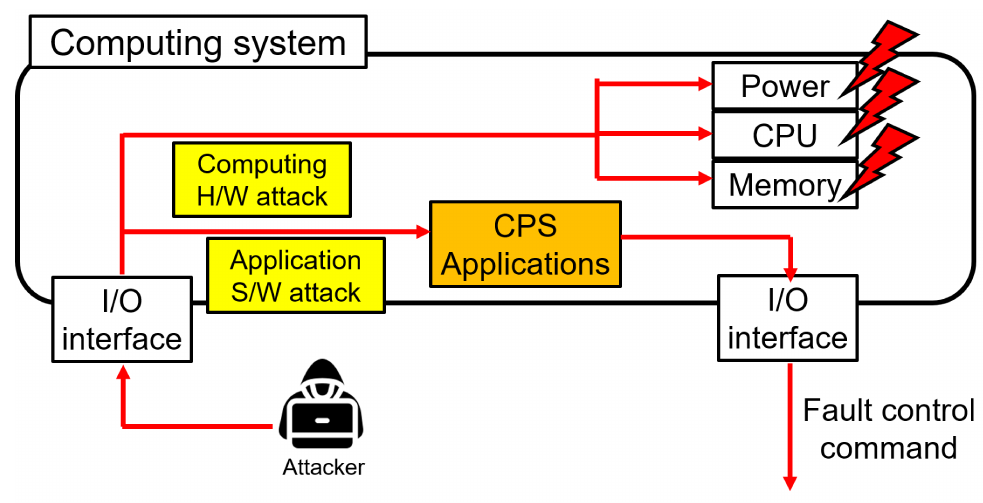
Figure 5. Cyber-physical attacks in the network